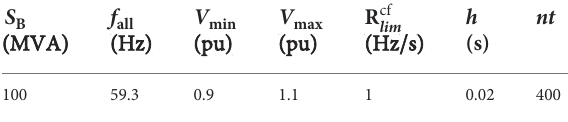
TABLE 2 Other parameters for calculation in 9-bus